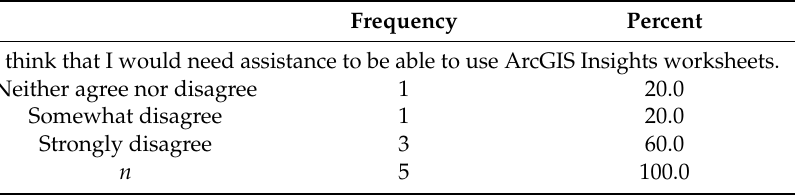
Table 6. Percentages and Frequencies, Q49.